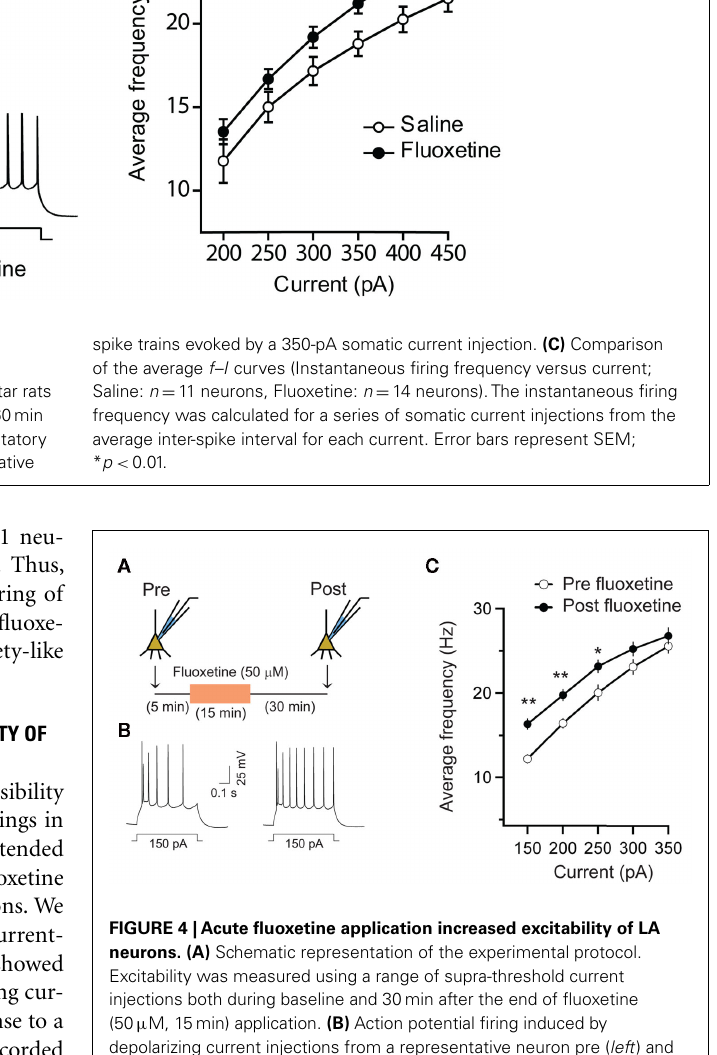
FIGURE 4 |Acute fluoxetine application increased excitability of LA neurons. (A) Schematic representation of the experimental protocol. Excitability was measured using a range of supra-threshold current injections both during baseline and 30min after the end of fluoxetine (50 μ M, 15min) application. (B) Action potential firing induced by depolarizing current injections from a representative neuron pre ( left ) and post ( right ) fluoxetine treatment. (C) Averaged firing frequency versus current relationship ( f–I curve) shows the increase in excitability after fluoxetine application ( n = 8 neurons) across a range of current injections. Error bars represent SEM; * p < 0.05, ** p <